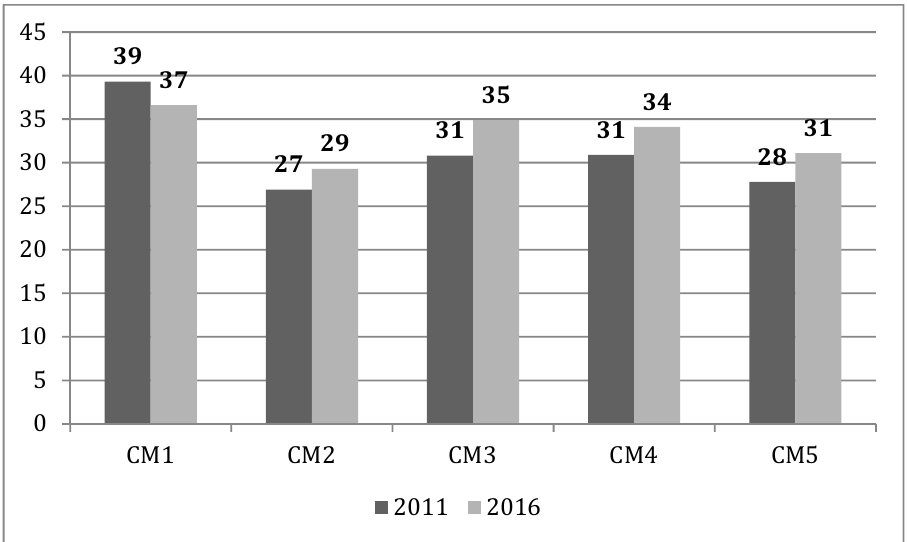
Figure 6. The results of the assessment of production criteria in 2011 and 2016 in the examined hard coal mines. Source: own work.